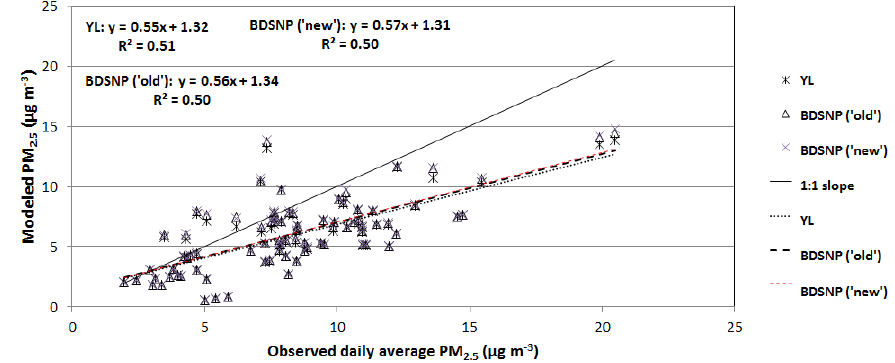
Figure 10. Comparison of the three in-line BDSNP–CMAQ cases with IMPROVE PM 2 . 5 data (Malm et al., 1994) in continental USA for the daily average PM 2 . 5 for July 2011. Table 3. Performance statistics of CMAQ modeled MDA8 Ozone for 16 CASTNET remote sites grouped into two categories: (a) 11 sites with moist or wet soil condition (monthly mean soil moisture (m 3 m − 3 ), θ mean >0.175), and (b) five sites with dry soil condition ( θ mean <0.175), using soil NO from YL and our two in-line BDSNP